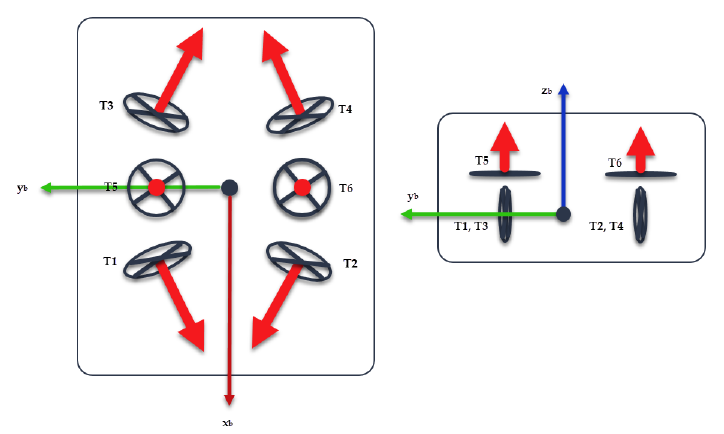
Figure 3. BlueROV2 thruster configuration. ( Left ) Top view. ( Right ) Front